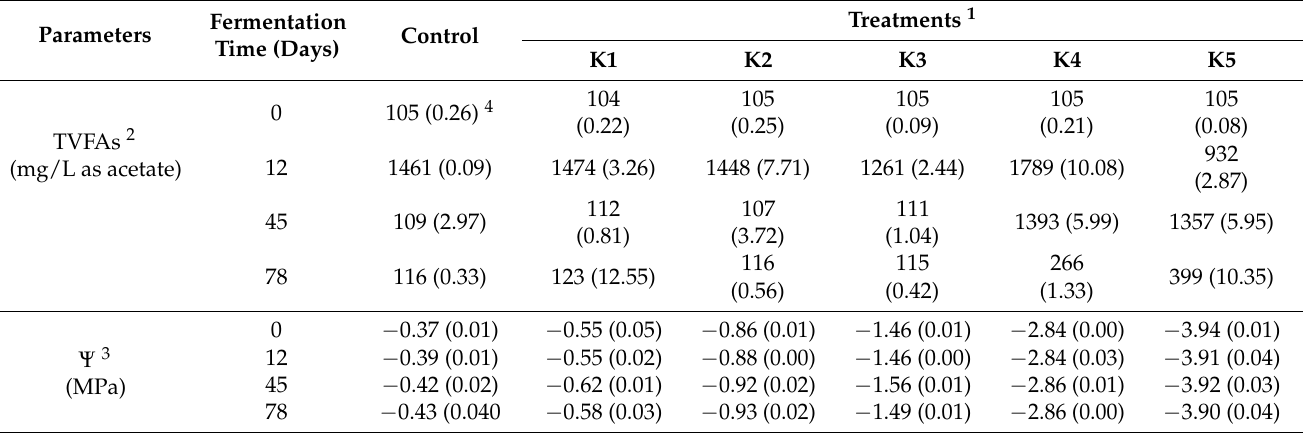
Table 6. Variation in the concentration of TVFAs and water potential ( Ψ ) during the water potential inhibition assay.